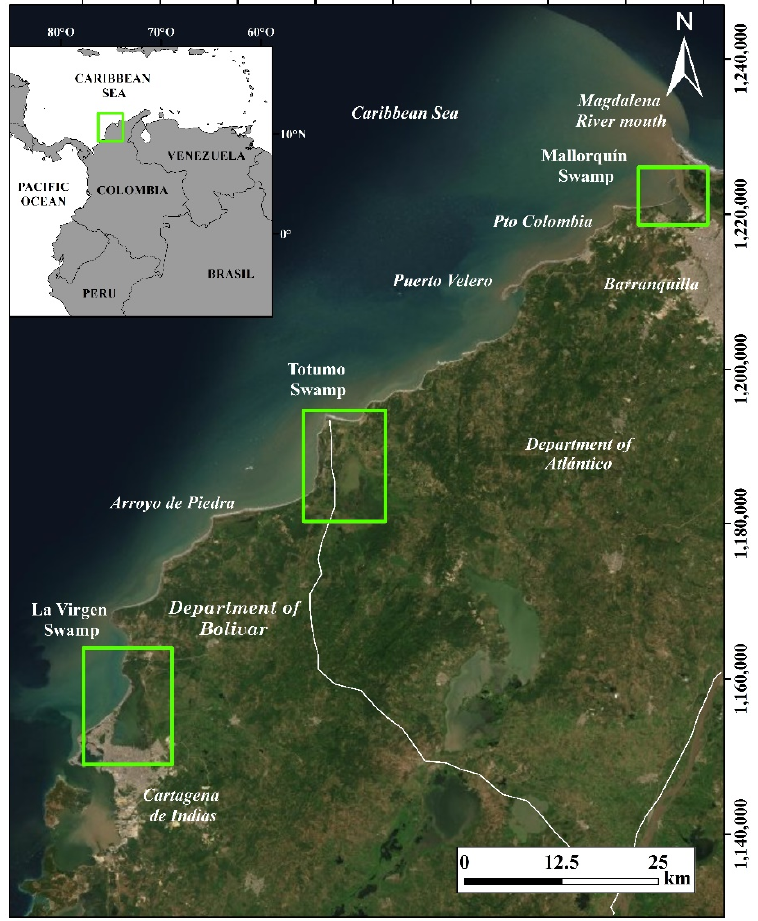
Figure 1. Location map with studied mangrove forests.